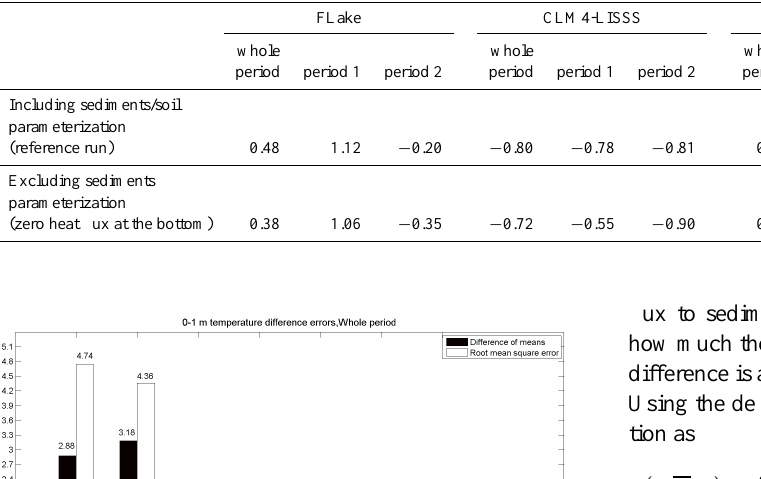
Table 3. The surface temperature DMs ( ◦ C) in reference run and in a run with zero heat flux at the lake bottom.